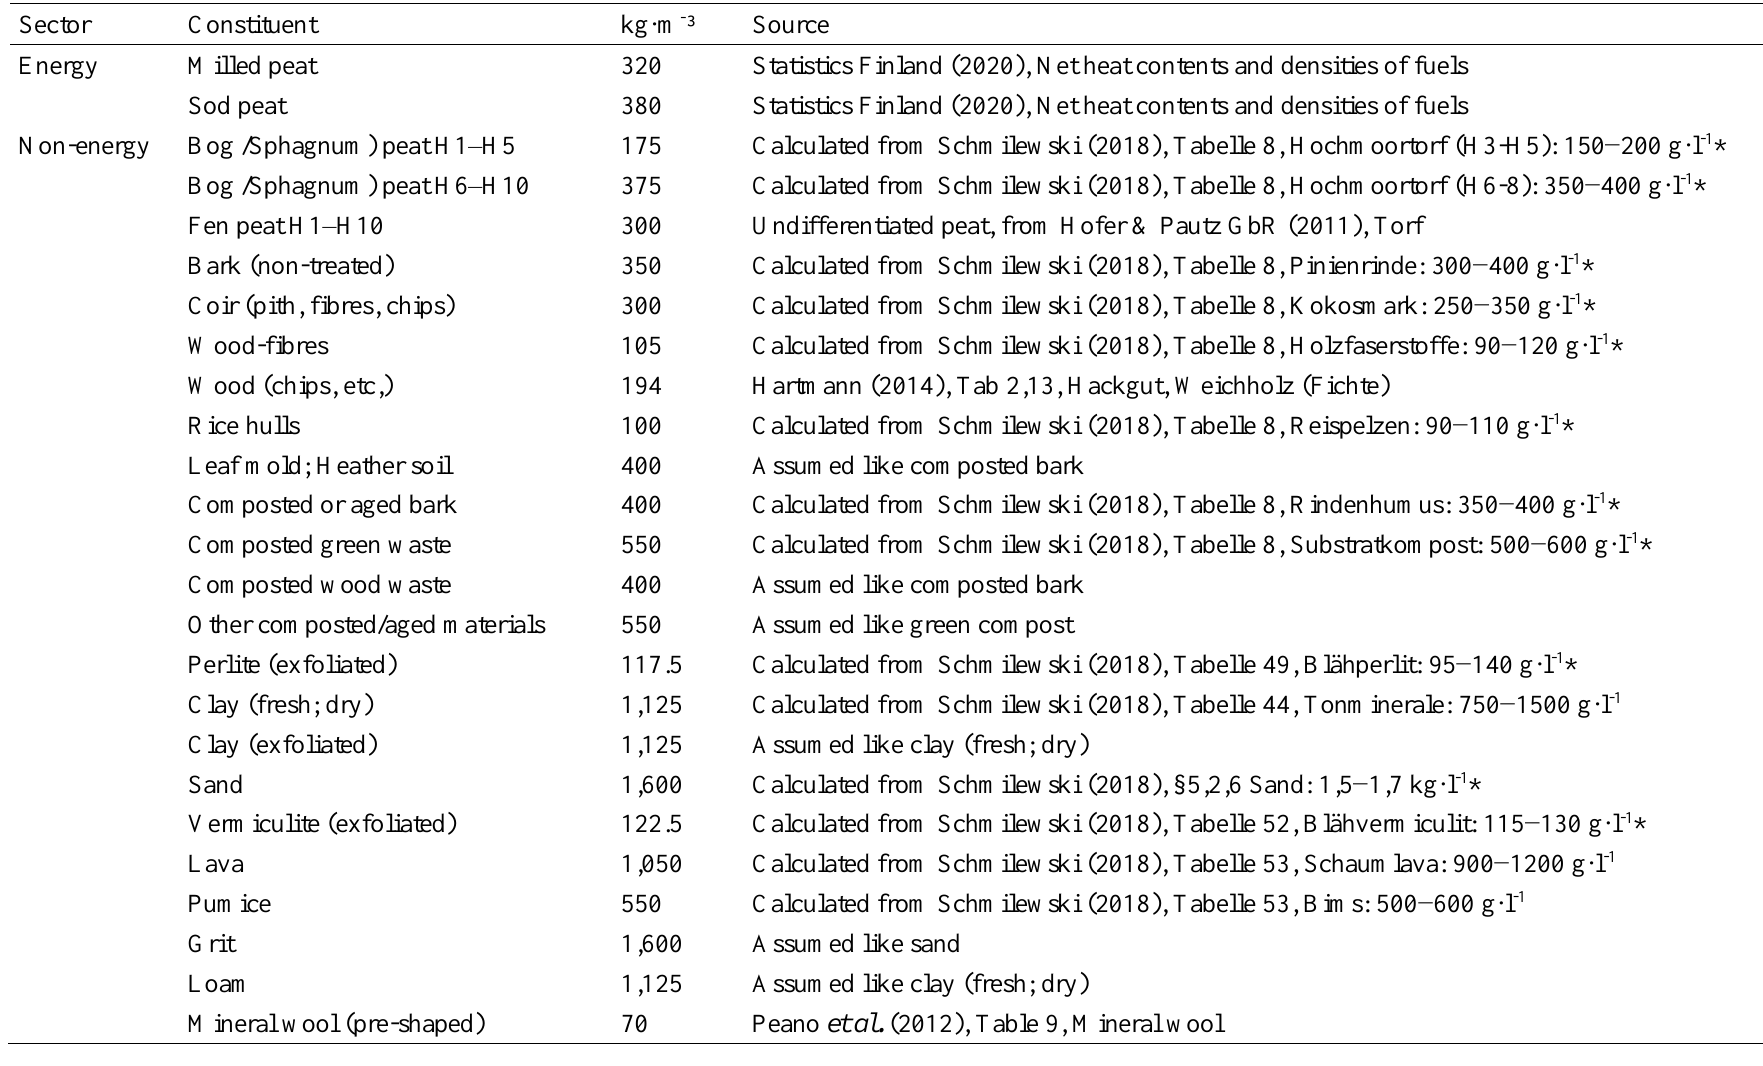
Table A6. Average density factors used as input. Unit: kg·m - ³. *density explicitly calculated using EN13040, in accordance with volume determination using EN12580.